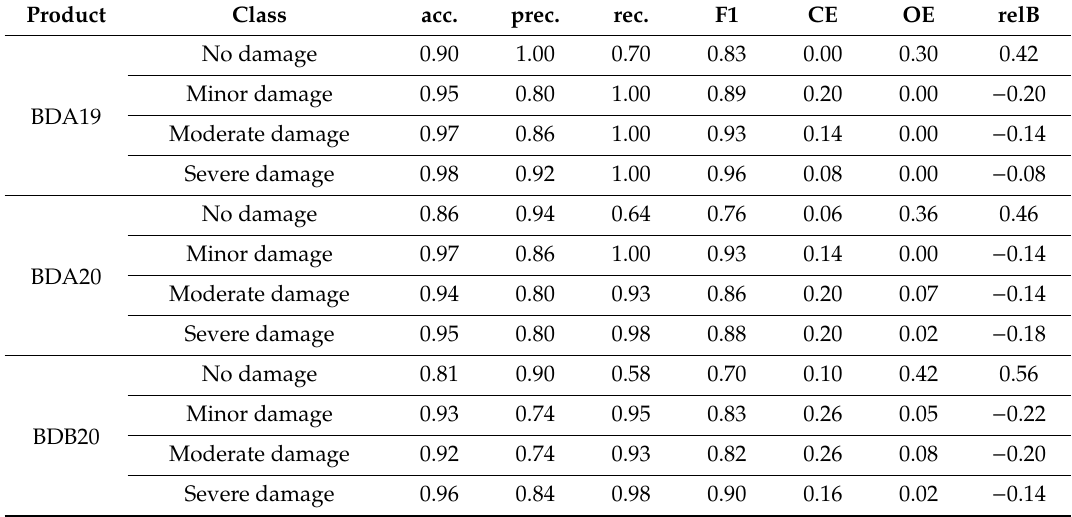
Table 4. Performance metrics by product and damage category. BDA, biotic damage A; BDB, biotic damage B; acc., accuracy; prec., precision; rec., recall; CE, commission error; OE, omission error; relB, relative